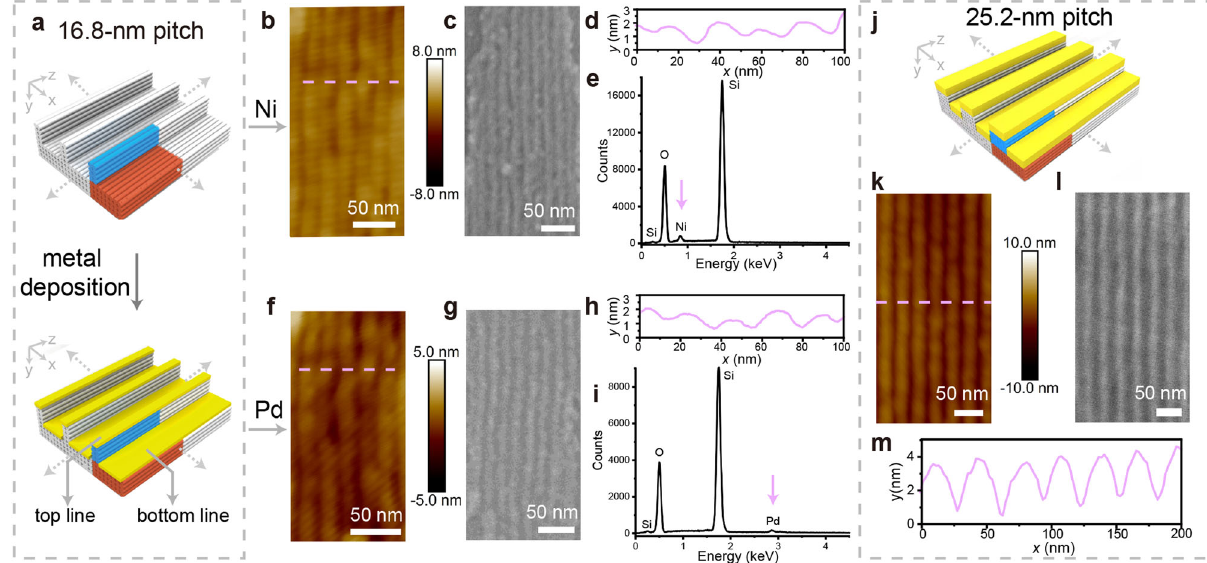
Fig. 6 DNA-directed fabrication of ultra-scaled metal nano-line arrays. a Design schematic for the DNA-directed metal deposition using 16-2w4h as template. b - i AFM images ( b , f ), SEM images ( c , g ), height pro fi les from AFM images ( d , h ), and element analysis via EDS ( e , i ) for the deposited Ni ( b – e ) and Pd ( f – i ) using DNA template with 16.8-nm designed line pitch, respectively. The pink dashed lines in b and f correspond to the positions for the height pro fi les in d and h . The scale bars in b , c , f , and g are 50 nm. Design ( j ), AFM image ( k ), SEM image ( l ), height pro fi le from AFM image ( m ) for the deposited Pd using DNA templates with 25.2-nm designed line pitch, respectively. The pink dashed line in k corresponds to the position for the height pro fi le in m . The scale bars in k and l are 50